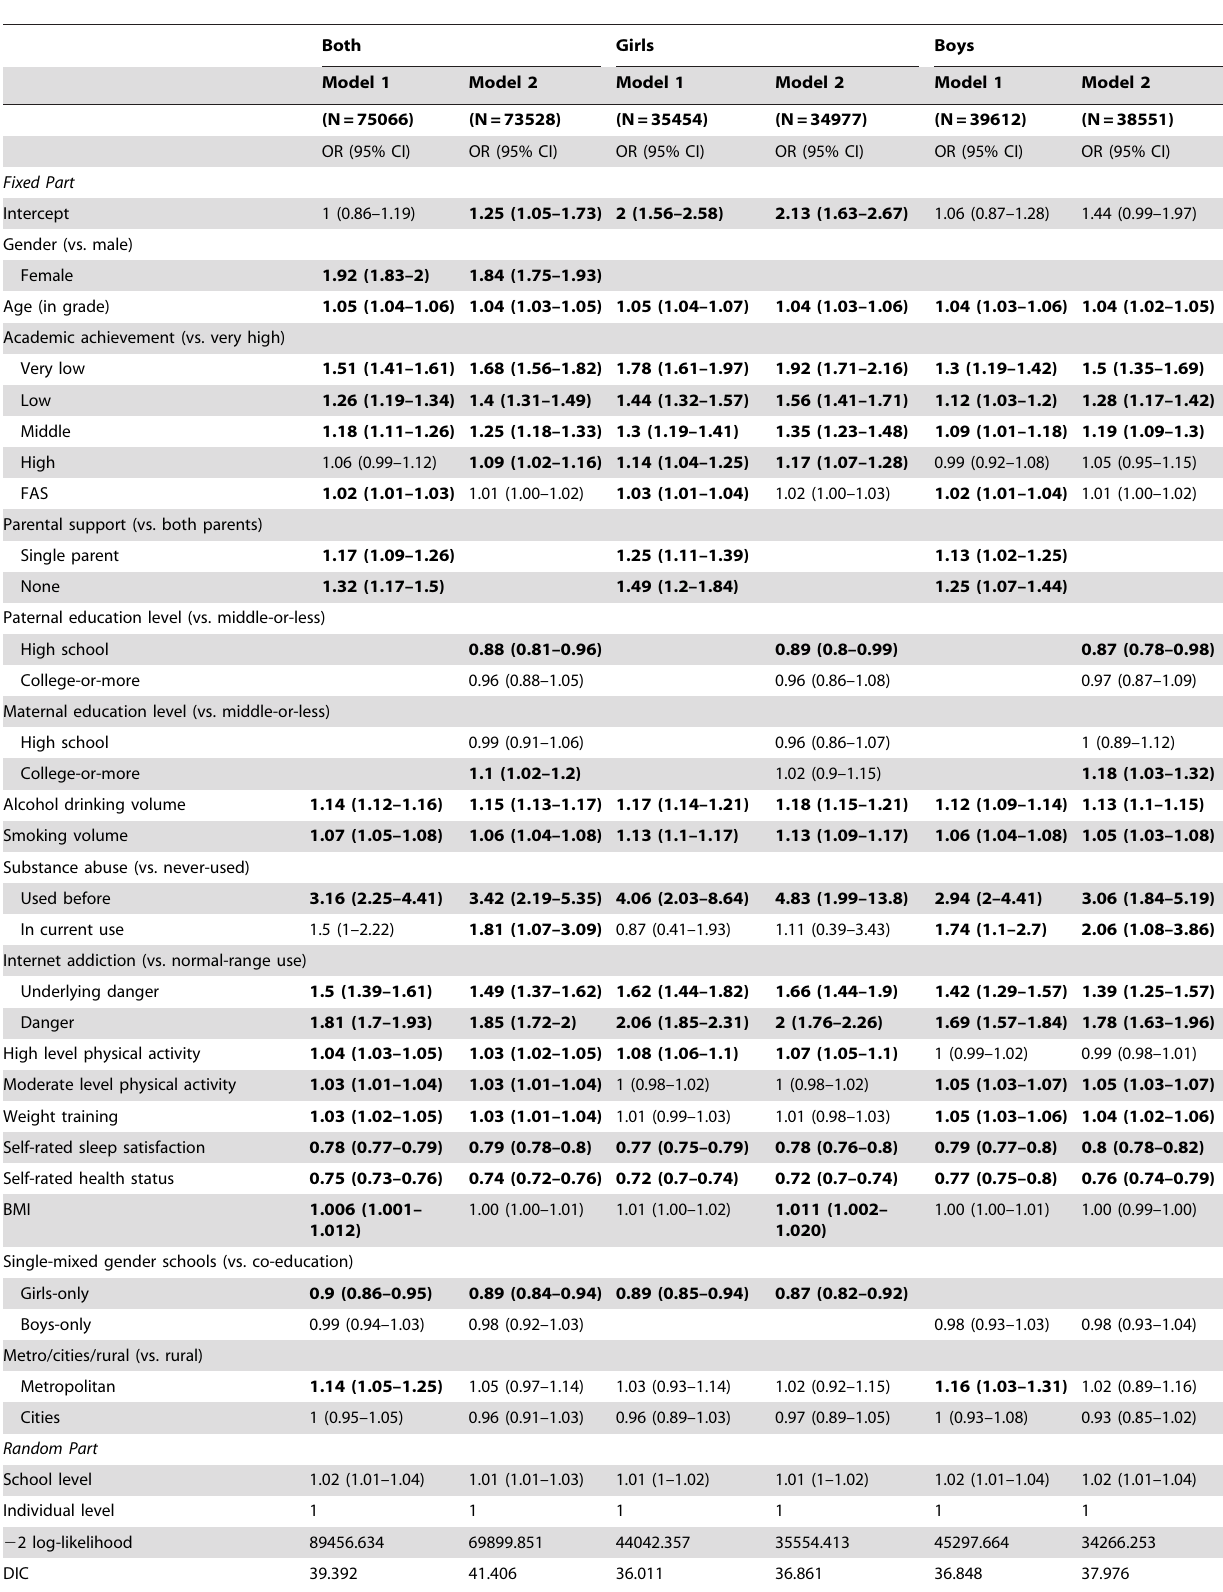
Table 2. Multilevel logistic regression estimates based on 2-level binomial logit model for ‘depression’ in Korean adolescents (divided by